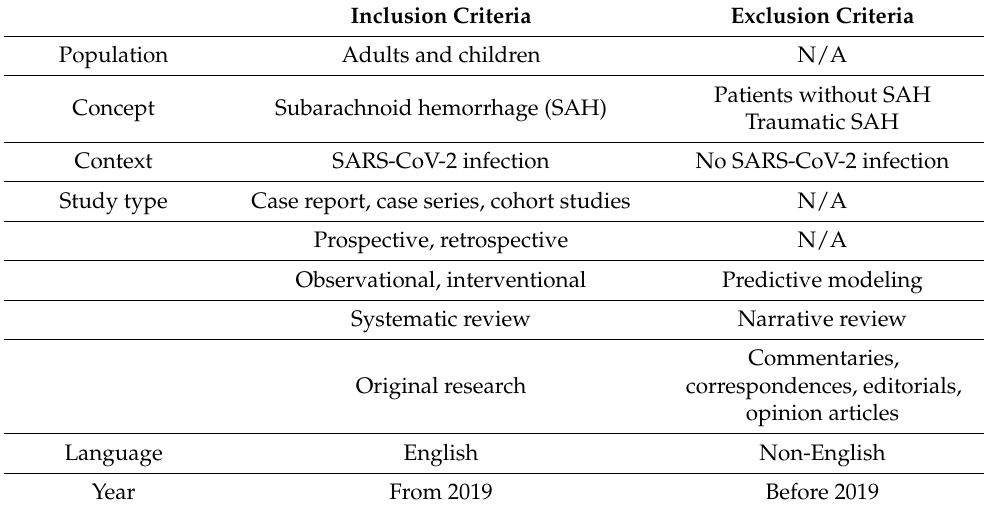
Table 1. Inclusion and exclusion